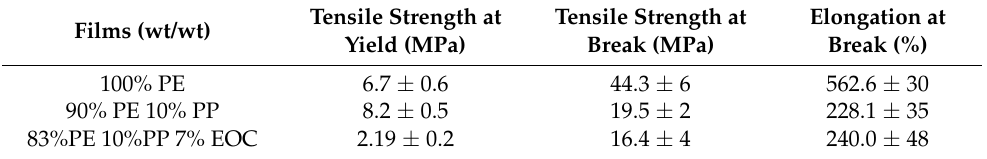
Table A1. Tensile strength properties of the PE/PP monolayer films in the machine direction